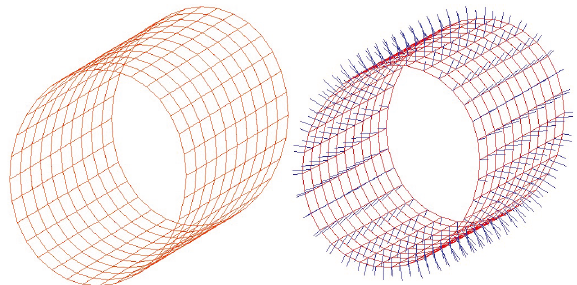
Figure 10: First excavation and blasting seismic wave application.